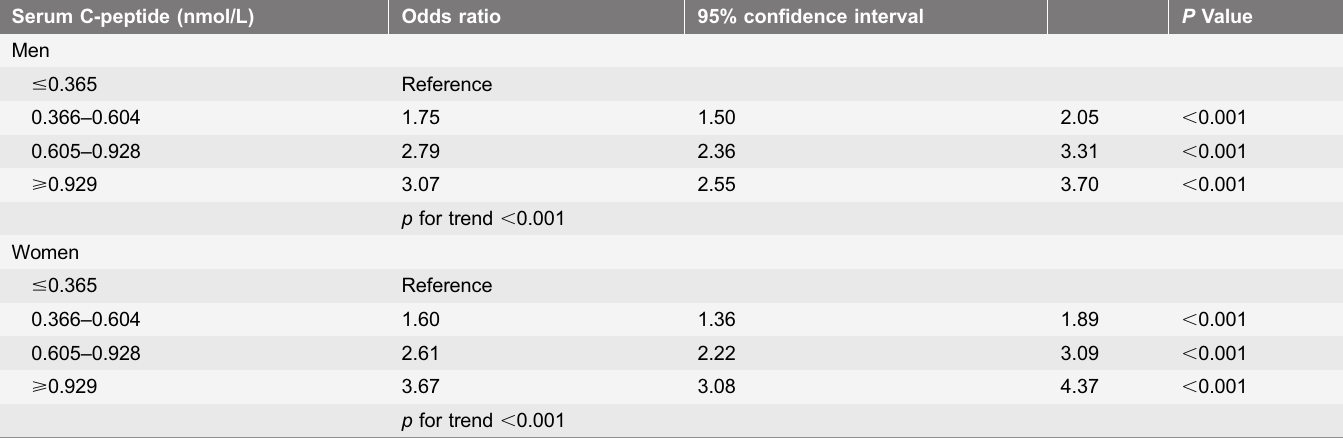
Table 3. The odds ratios of quartiles of serum C-peptide levels for low serum HDL-C levels. Serum C-peptide (nmol/L)